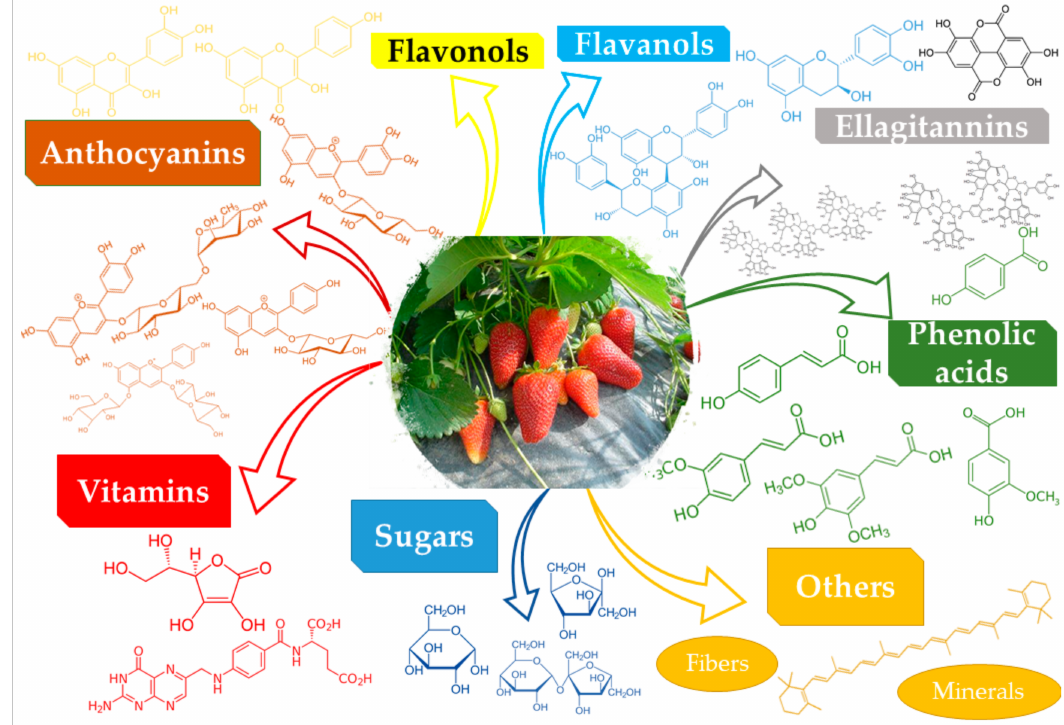
Figure 1. Main components Fragaria species identified according literature